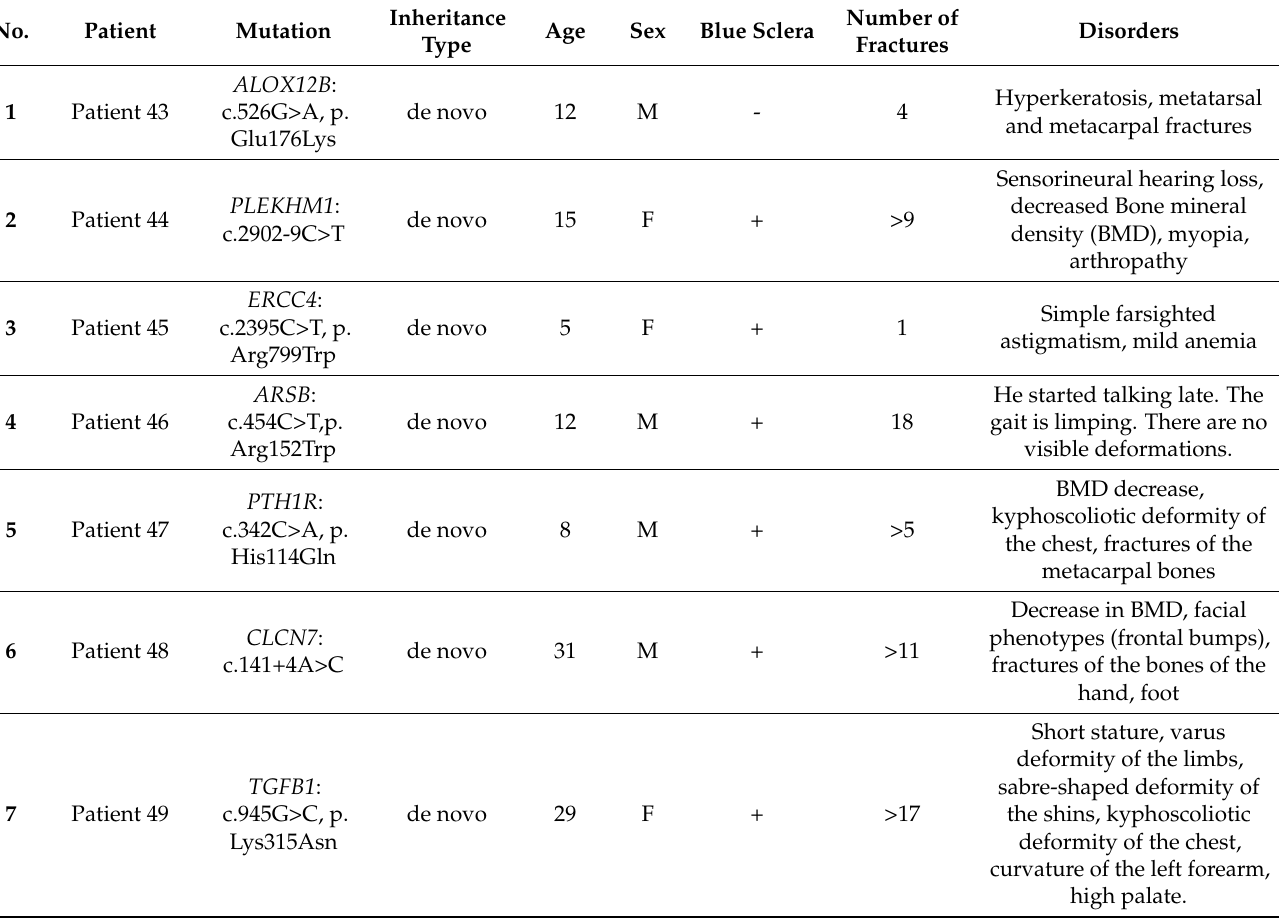
Table 3. Clinical characteristics of patients with mutations in non-collagen